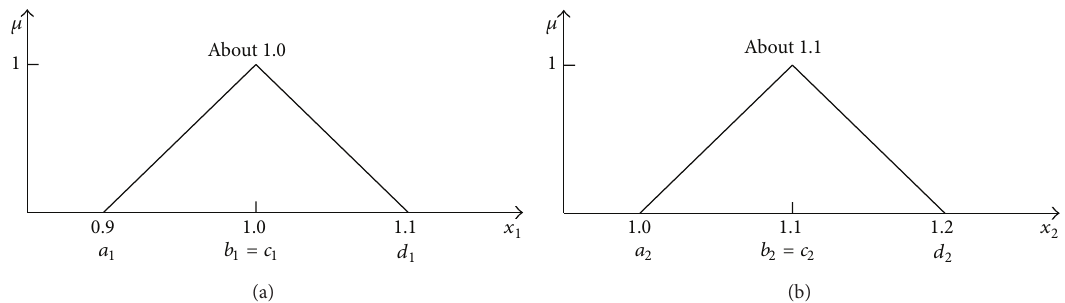
Figure 7: Membership functions of uncertain weights 𝑋 1 and 𝑋 2 of two stones S1 and